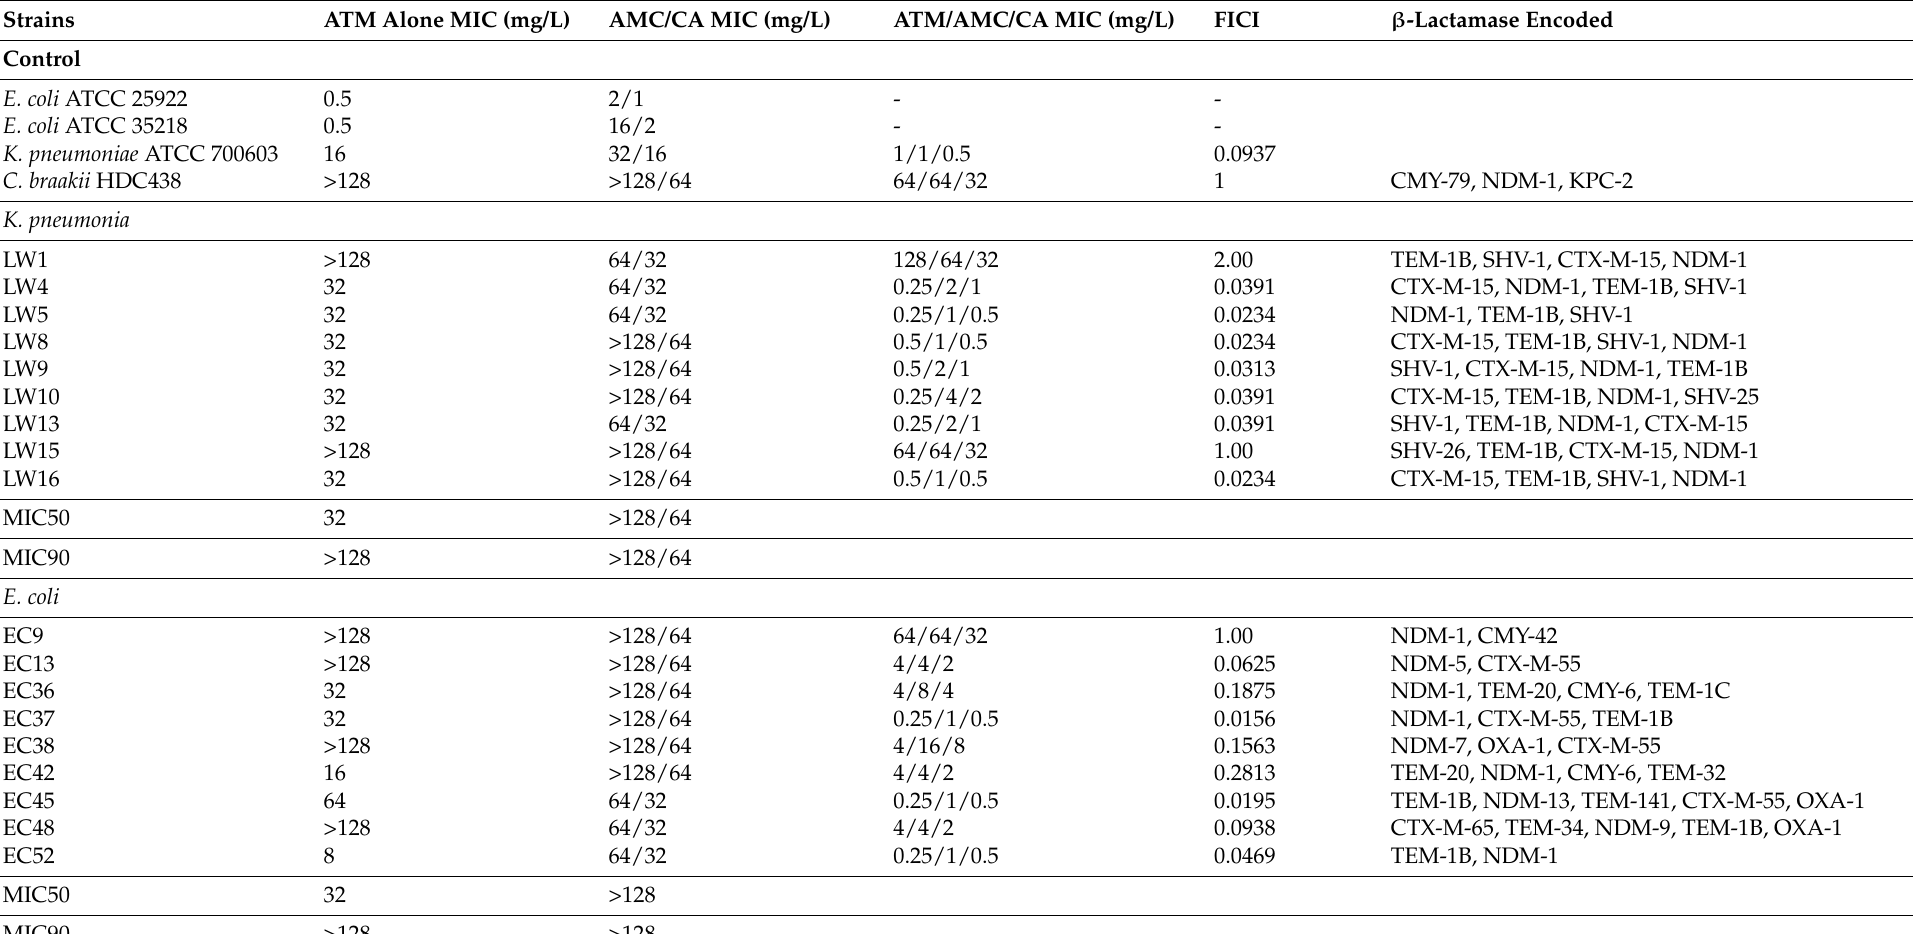
Table 2. Minimum inhibitory concentrations (MIC) of aztreonam (ATM) alone, amoxicillin/clavulanate (AMC/CA, 2:1 ratio) and aztreonam/amoxicillin/clavulanate (ATM/AMC/CA) against K. pneumonia and E. coli isolates, as well as β -lactamase genes encoded in each